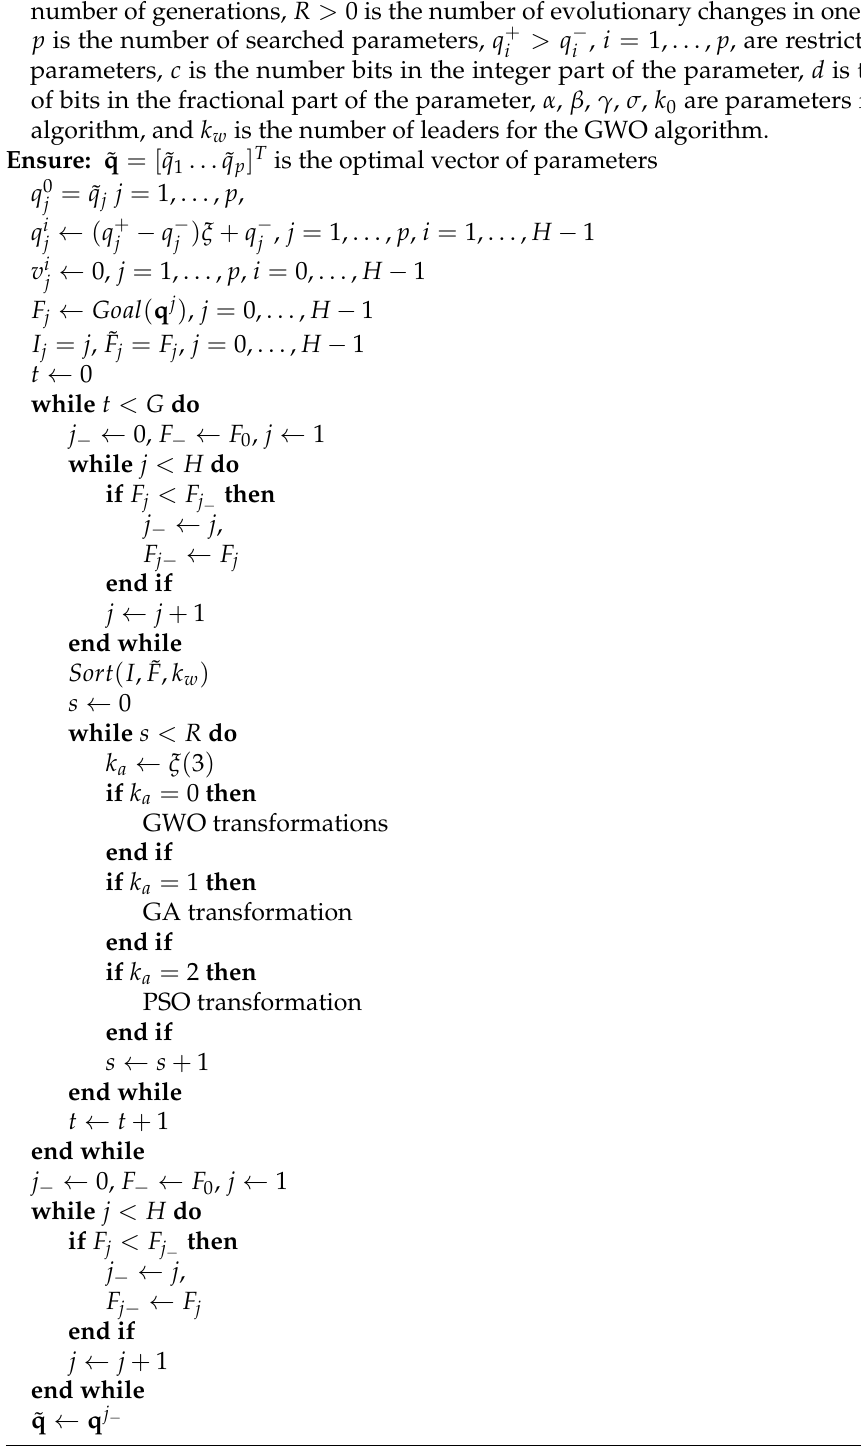
Algorithm A1 Hybrid